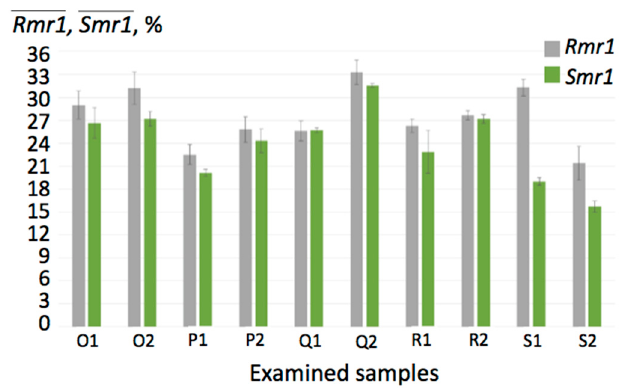
Figure 9. Average results on a material proportion of the profile Rmr 1 and respective topography parameter Smr 1 of the bearing ring samples.